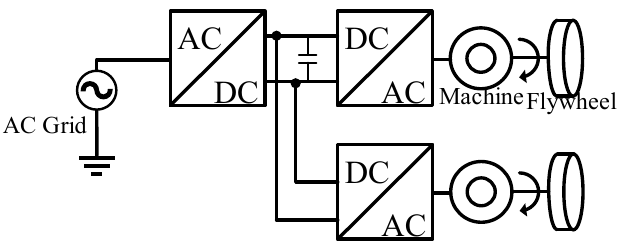
Figure 28. Schematic diagram of the DC bus integration system with flywheel.